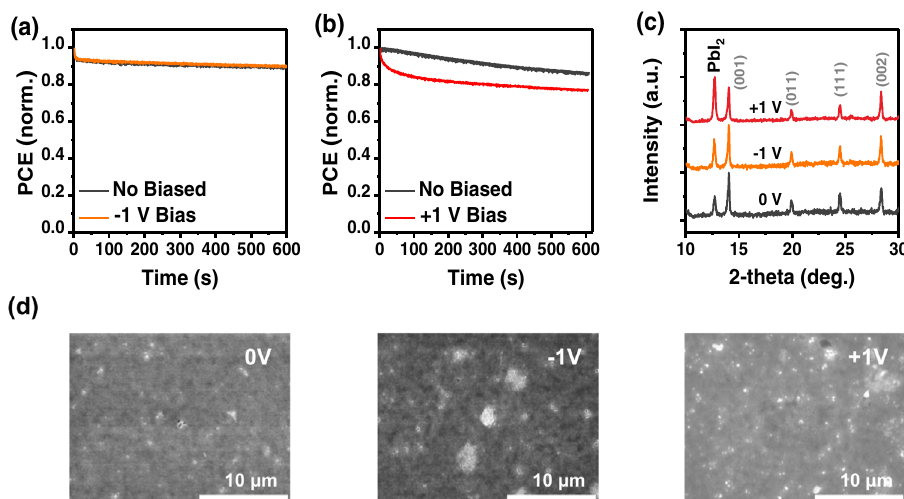
Fig. 5 SPO, XRD and SEM images. Comparisons of the SPOs for the PSCs tracking at the MPP before and after applying electric stress: a − 1 V and b + 1 V. c XRD patterns for the samples cleaved from the full device with and without electric stress (0 V, − 1 V, and + 1 V for 12 h). d Top-view SEM images of the corresponding cleaved